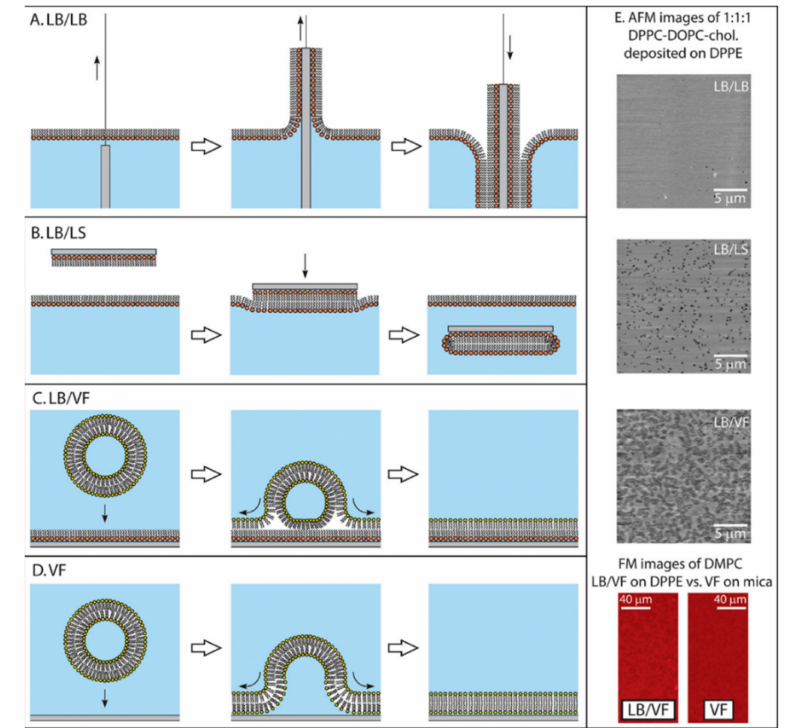
Figure 3. ( A ) Schematic Langmuir–Blodgett (LB) deposition of solid-supported bilayers. (Left)